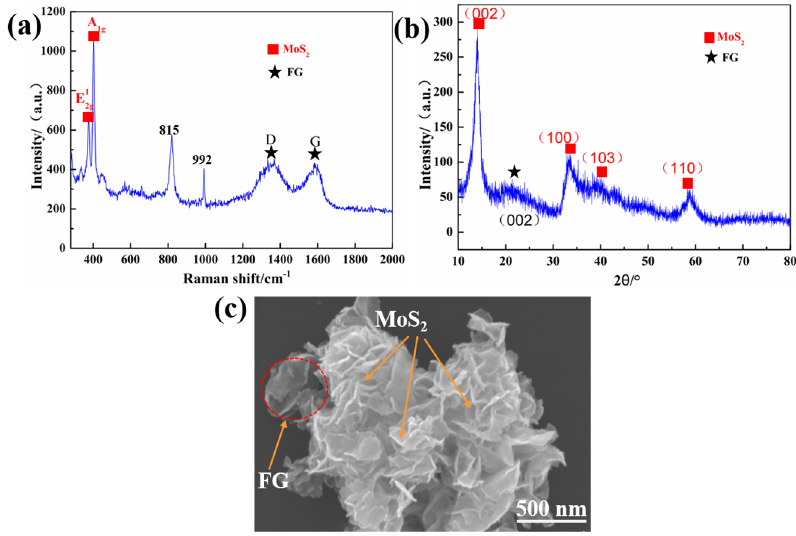
Figure 2. ( a ) Raman spectrum of FGr@MoS 2 hybrid, ( b ) XRD pattern of FGr@MoS 2 hybrid, and ( c ) SEM image of FGr@MoS 2 hybrid. ( c ) SEM image of FGr@MoS 2